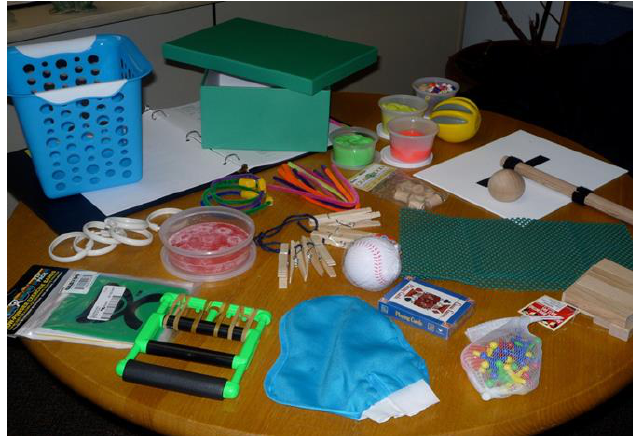
Figure 1. Tool kit for iCIMT